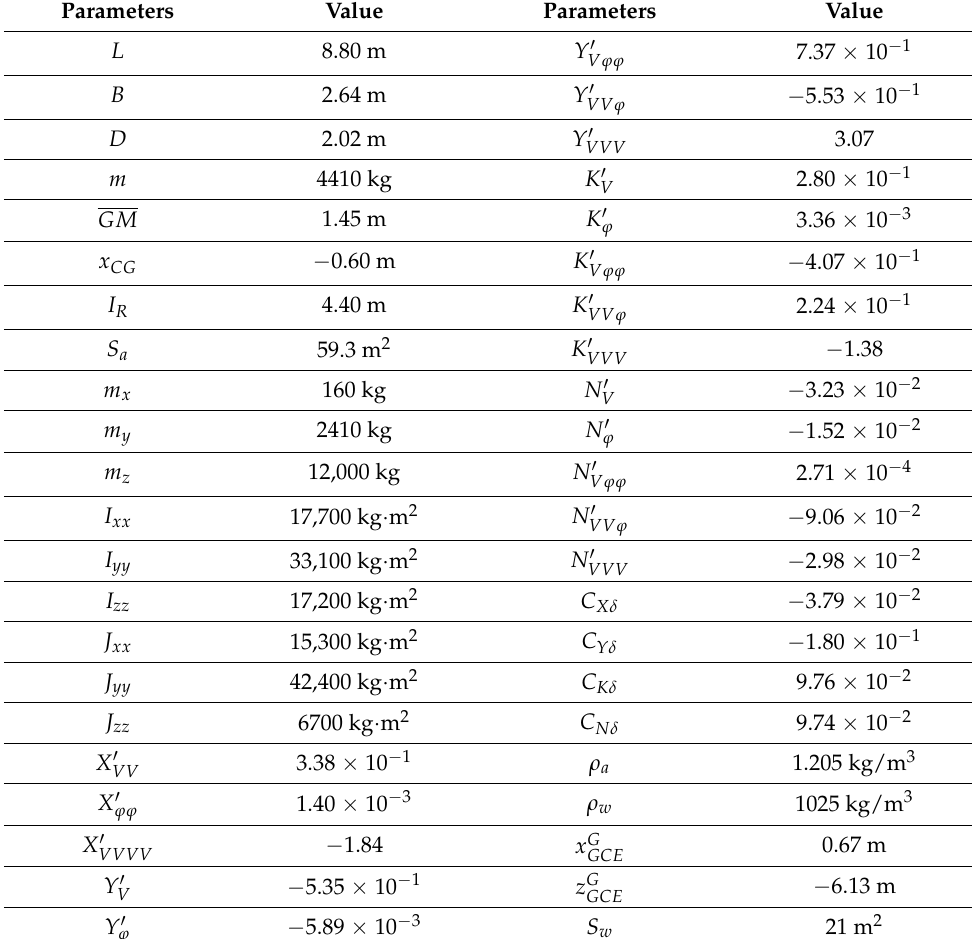
Table 1. Fujin-class unmanned sailboat parameters.